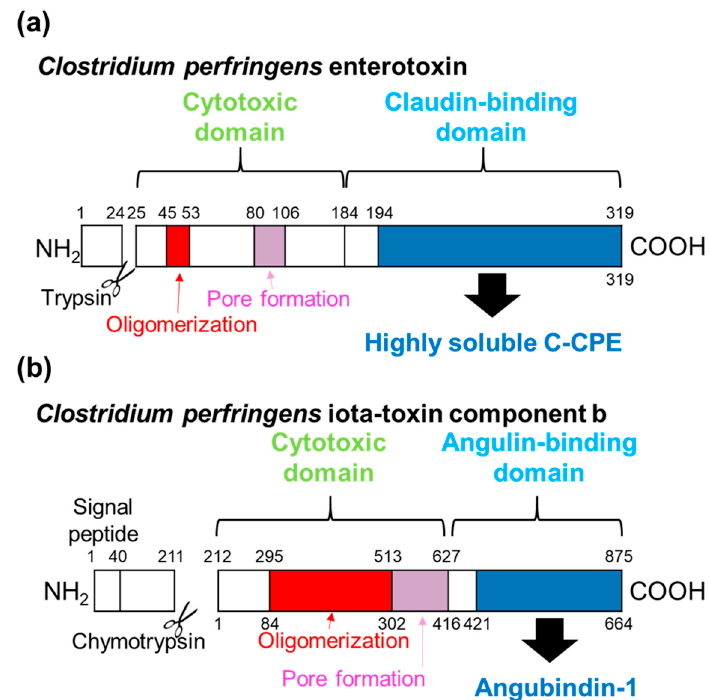
Figure 2. Schematic diagram showing the domains of first-generation claudin binders made from bacterial toxins. ( a ) Clostridium perfringens enterotoxin and ( b ) C. perfringens iota-toxin. Regions involved in oligomerization (red) and pore formation (pink) are indicated. Regions used as first-generation claudin binders are indicated in blue. The accession numbers for C. perfringens enterotoxin and iota-toxin are AOD41705 and CAA51960, respectively.